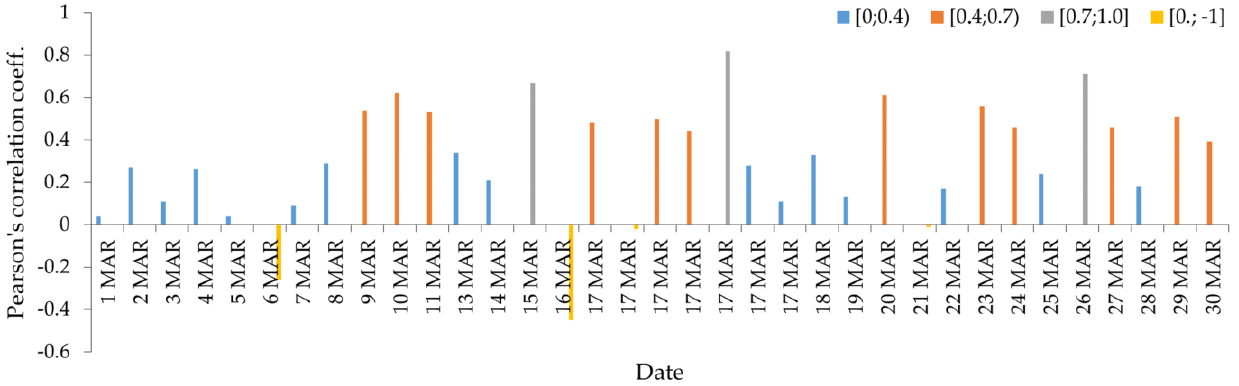
Figure 10. Pearson’s correlation coefficients in relation to the peak discrepancies on 1 March and the peaks on other days.